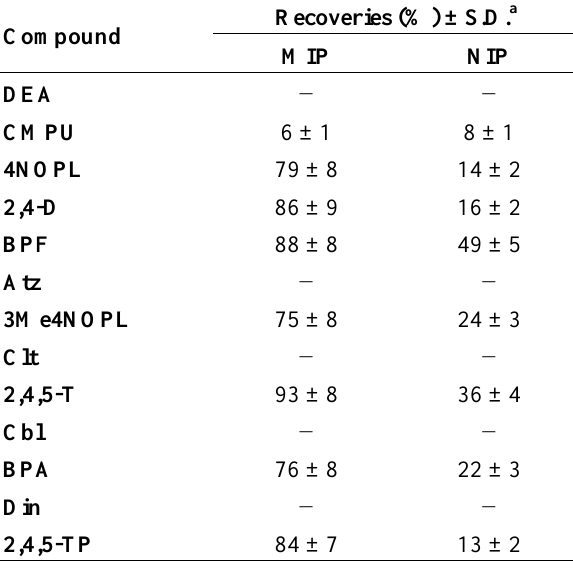
Table 1. Recoveries (%) of some xenobiotic compounds employed to study the selectivity of MIP and NIP. Sample: 5 mL of UHQ water spiked with 100  g L −1 of each analyte. Washing solvent: 10 mL of dichloromethane. Recoveries (%) ± S.D. a Compound MIP NIP DEA